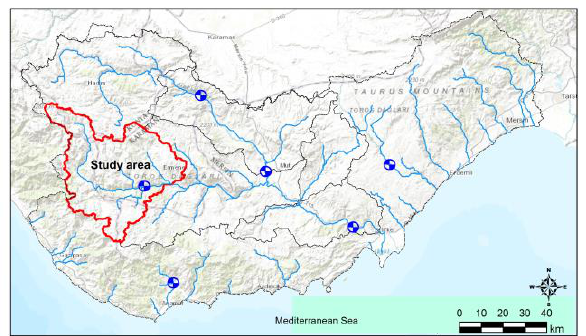
Fig.1. Location of the Ermenek Subcatchment in the